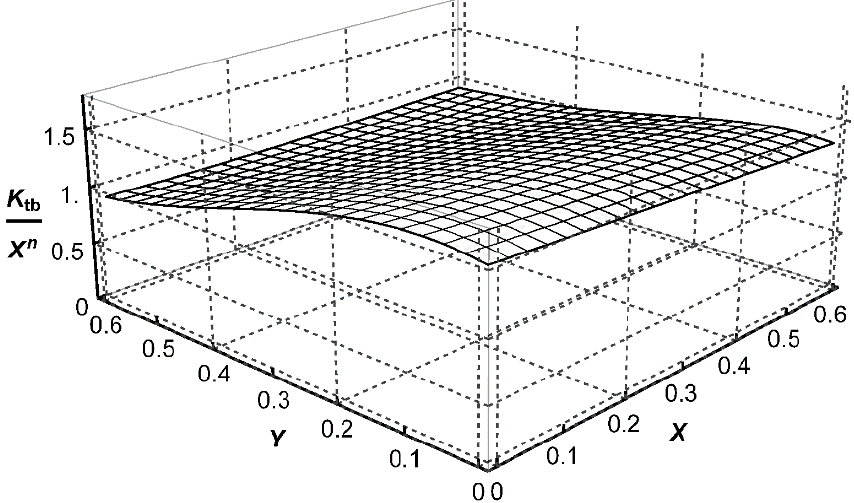
Figure 7. Graphical representation of the function P t = K tt / X n for θ = 45 ◦ , n = − 0.3264 and Z 0 = 1.